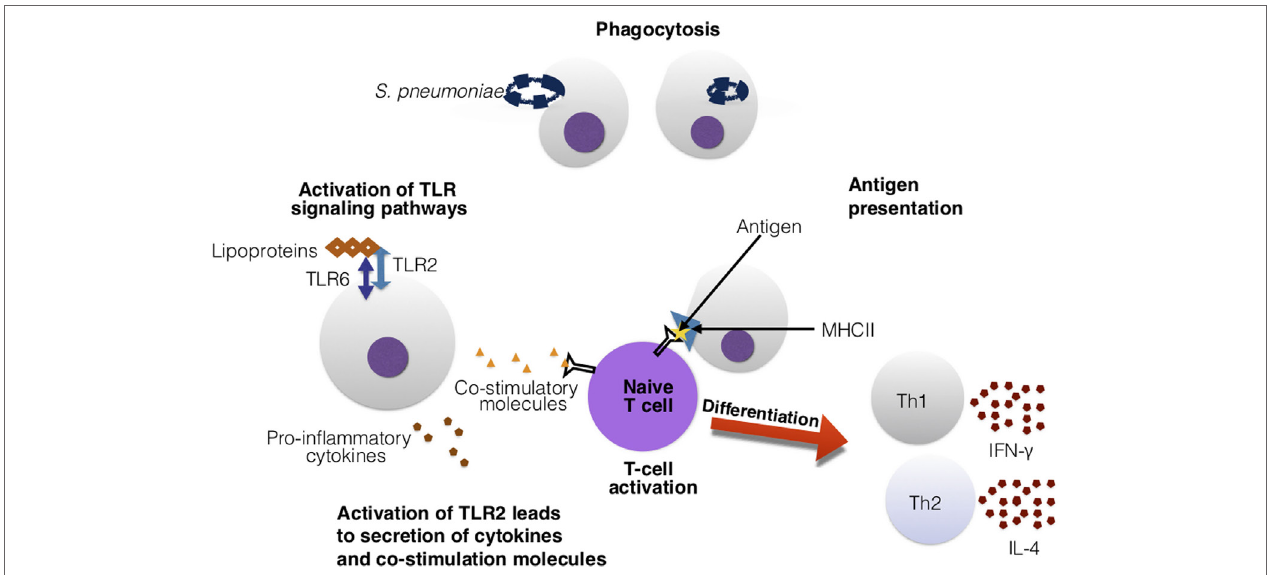
FigURe 9 | Toll-like receptors (TLRs) assist in the activation of adaptive immune cells. In this figure, TLR2 recognizes the Streptococcus pneumoniae’s lipoproteins . Upon activation, TLR2 secretes cytokines and co-stimulatory molecules. These co-stimulatory molecules are essential for co-stimulation and activation of T cells. The T cell is presented an antigen with major histocompatibility complex (MHC)II and antigen-presenting cell. The recognition of the antigen–MHCII complex and the co-stimulatory molecules activates the T cell and leads downstream to differentiation into Th1 and Th2 cells, that can release various cytokines such as interferon- gamma (IFN)- γ and interleukin